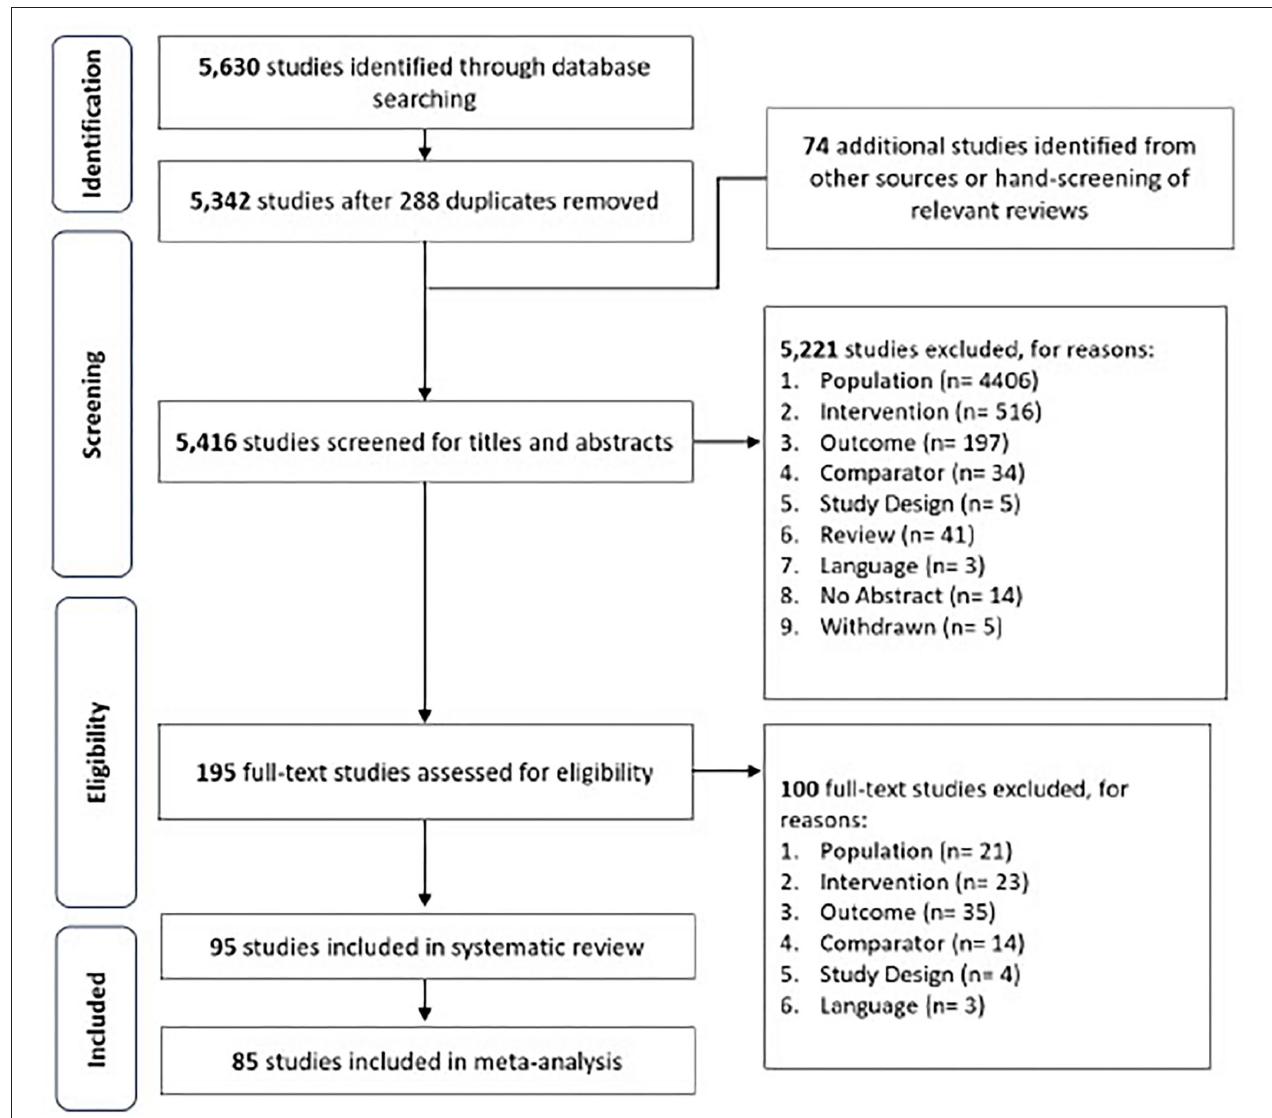
FIGURE 1 | Flow diagram of study